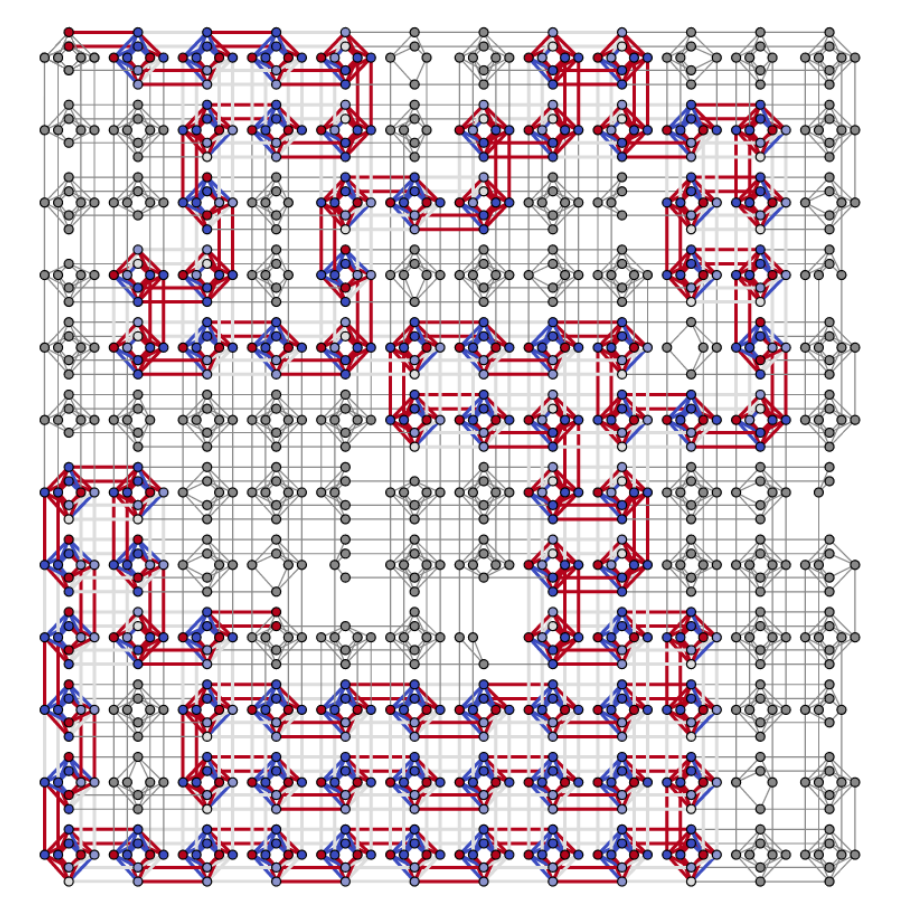
Figure 17. Illustration of our implementation for a vector x with 82 coordinates on a real D-Wave 2X hardware, which vector is constrained to contain exactly one + 1